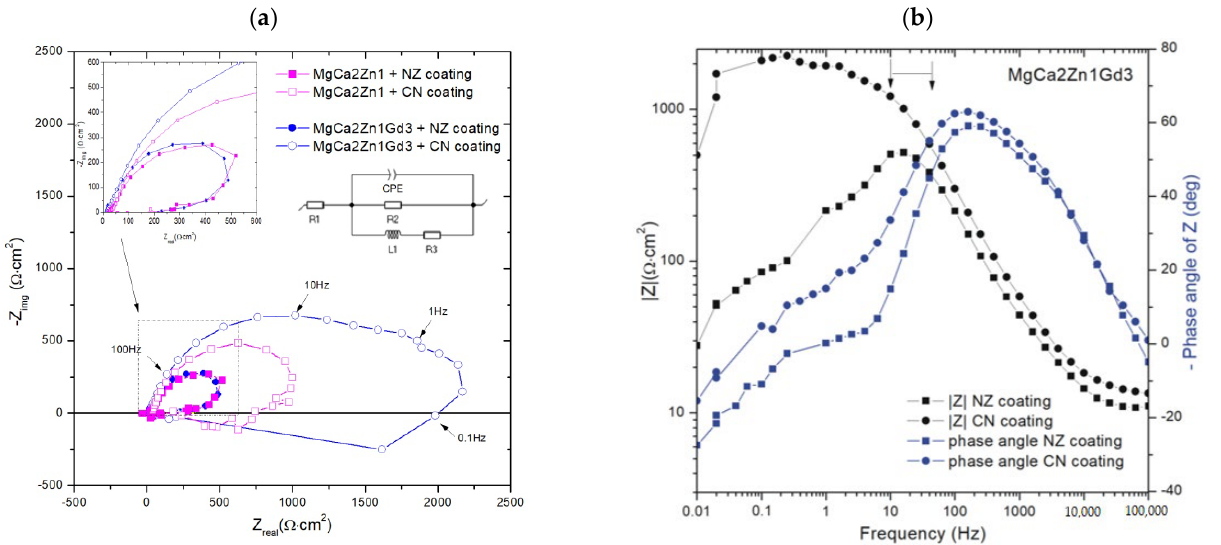
Figure 10. EIS results in ( a ) Nyquist plot of experimental data of conversion coatings on Mg-based alloys and adopted EEC circuit; ( b ) Bode plot of fitted data of casein (CN) and casein-free (NZ) coatings on MgCa2Zn1Gd3 alloy.